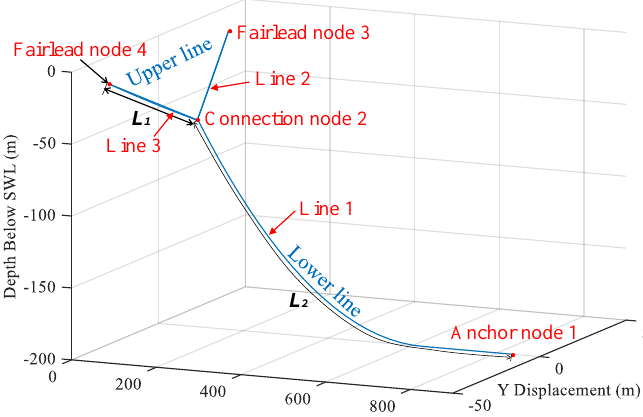
Figure 3. Connection form of the multi-segment mooring lines.